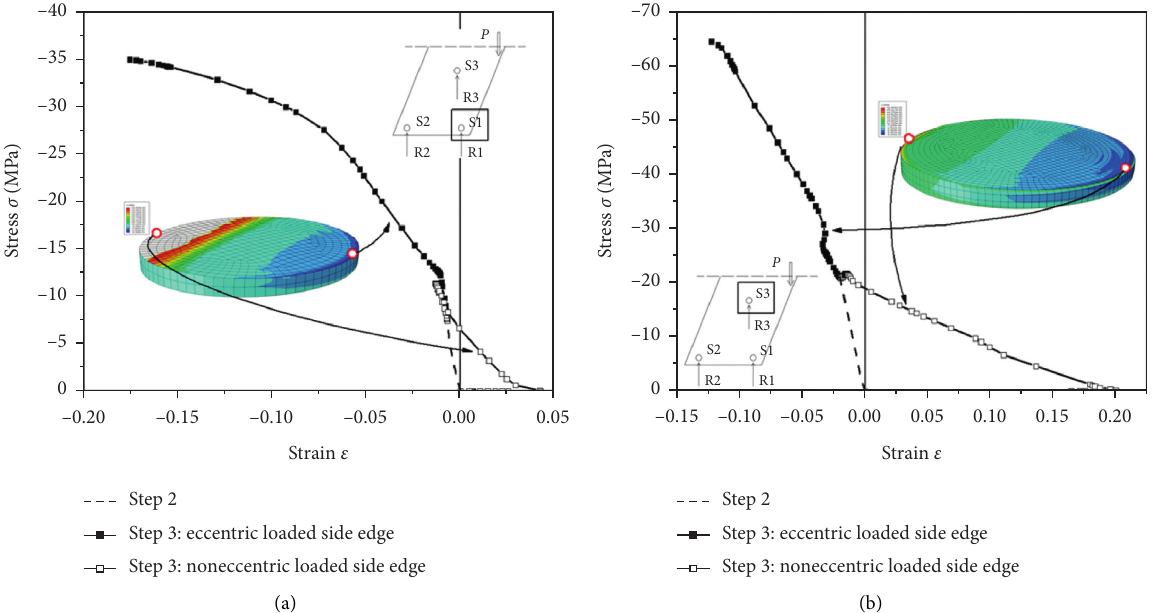
Figure 12: Stress-strain curves of the edge of the rubber pads calculated from the solid model. (a) End bearing on the eccentric loaded side S1. (b) Middle bearing